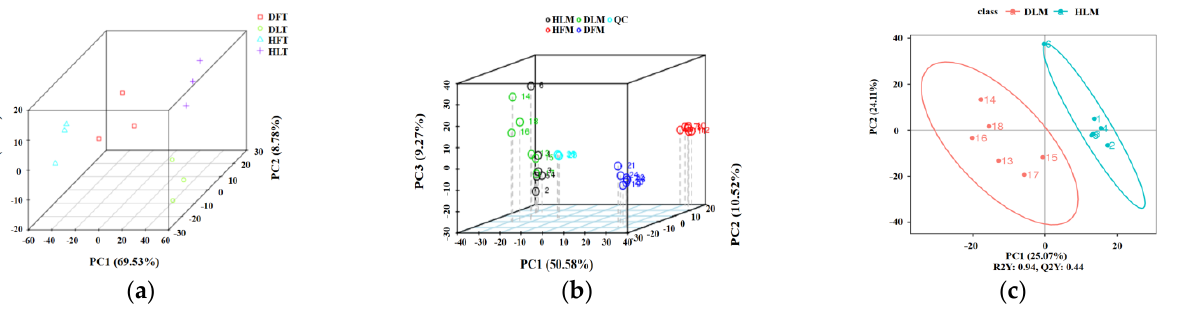
Figure 2. Principal component analysis (PCA) plots for RNA-seq data and mass spectrum data of Citrus reticulata Blanco ‘Shatangju’ samples and the quality control of the samples. ( a ) The PCA 3D plot of the transcriptomic (T) on four groups of samples. ( b ) The PCA 3D plot on four groups of samples based on metabolomics (M) data. ( c ) The PLS-DA score plot of two groups of leaf samples based on metabolomics (M) data. The abscissa PC1 and the ordinate PC2 represent the scores of the first and second principal components, respectively. The scattered points of different colors represent the samples of the different experimental groups. DF, diseased fruit pith. DL, diseased leaf. HF, healthy fruit pith. HL, healthy leaf. T, transcriptome analysis. M, metabolome analysis.